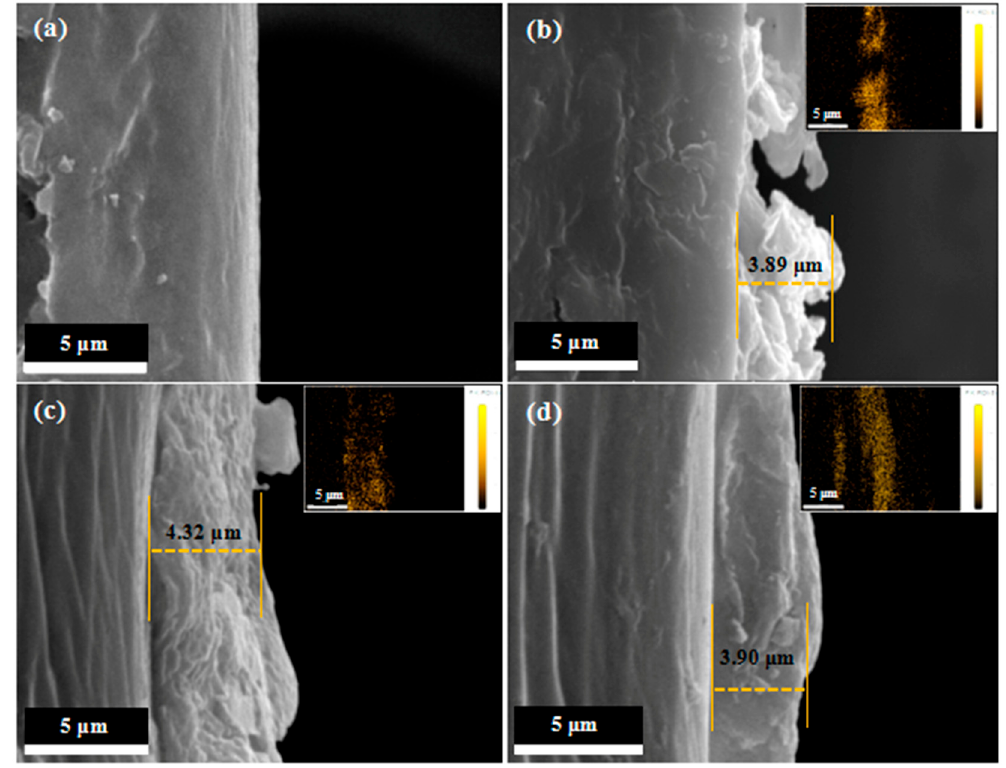
Figure 4. SEM images represent the cross sections of ( a ) pristine film, ( b ) M 1 -2, ( c ) M 2 -2, and ( d ) M 3 -2. The illustrations correspond to the mapping photos of F element of ( b ) M 1 -2, ( c ) M 2 -2, and ( d ) M 3 -2.